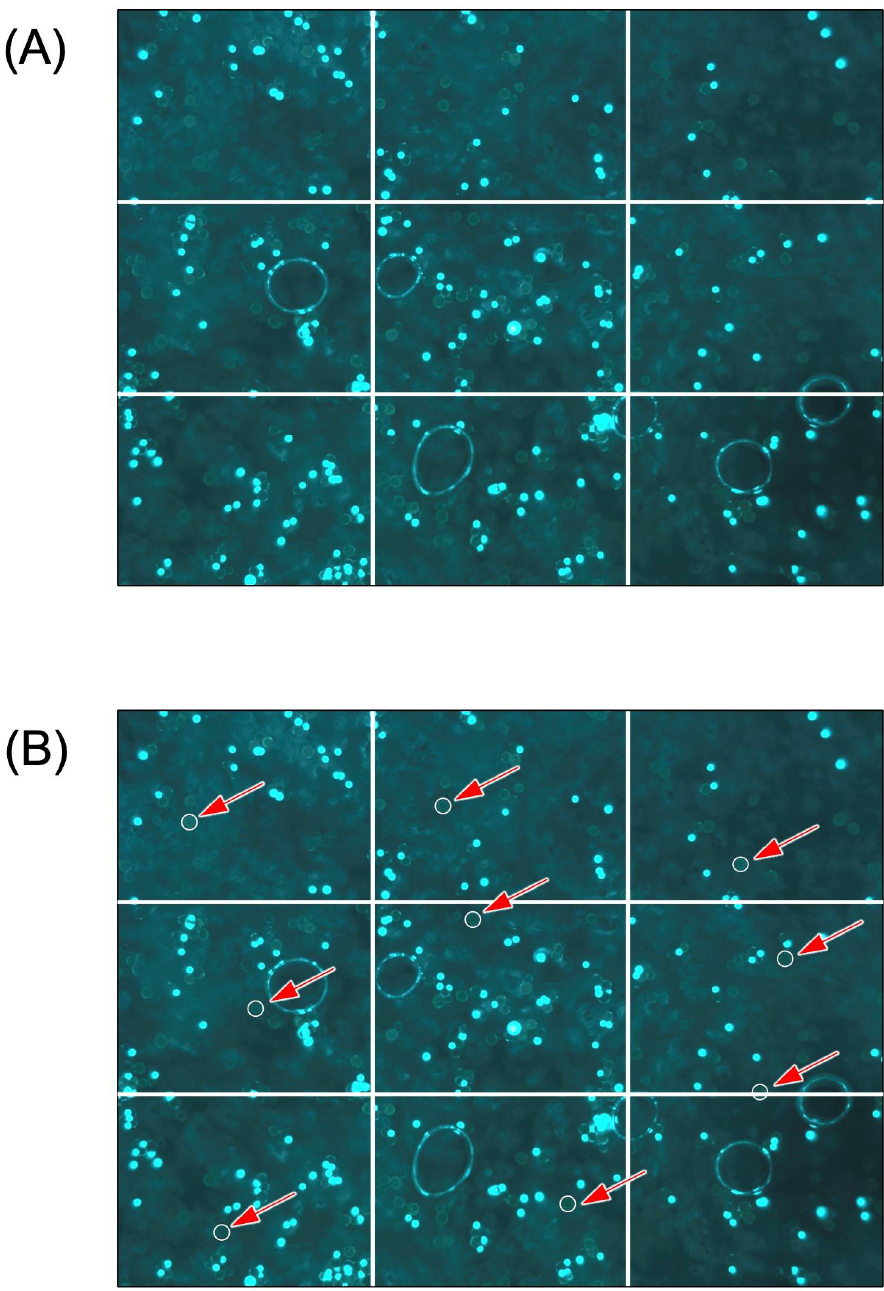
Figure 1. Fluorescent microscopic images of PS microplastics stained with Nile Red and URFP-100 particles ( A ). The image was divided into nine areas and a single independent particle was selected for each area (pointed out by red arrows in ( B ) for analysis of fluorescent intensity. URFP-100 was used as a standard for fluorescent intensity between